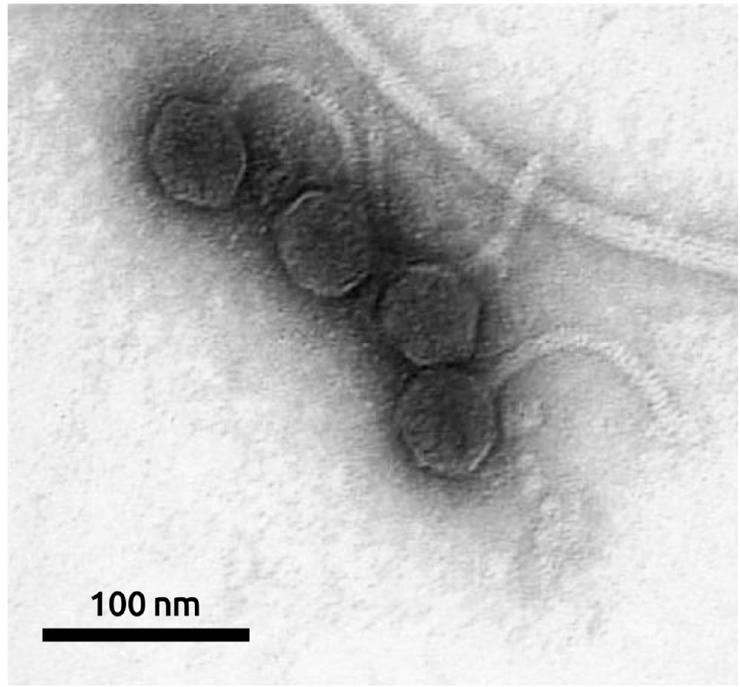
Figure 2. Electron microscopy image of phage MD8. The scale bar is 100 nm.